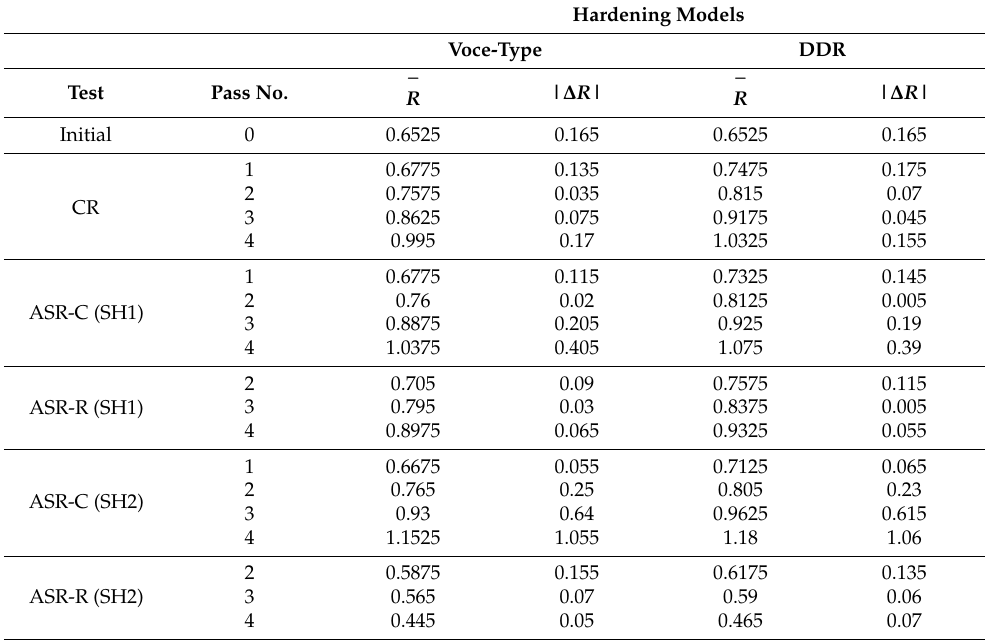
Table 5. Normal and planar anisotropy coefficients for four-pass rolling sequences with a 20% reduction per